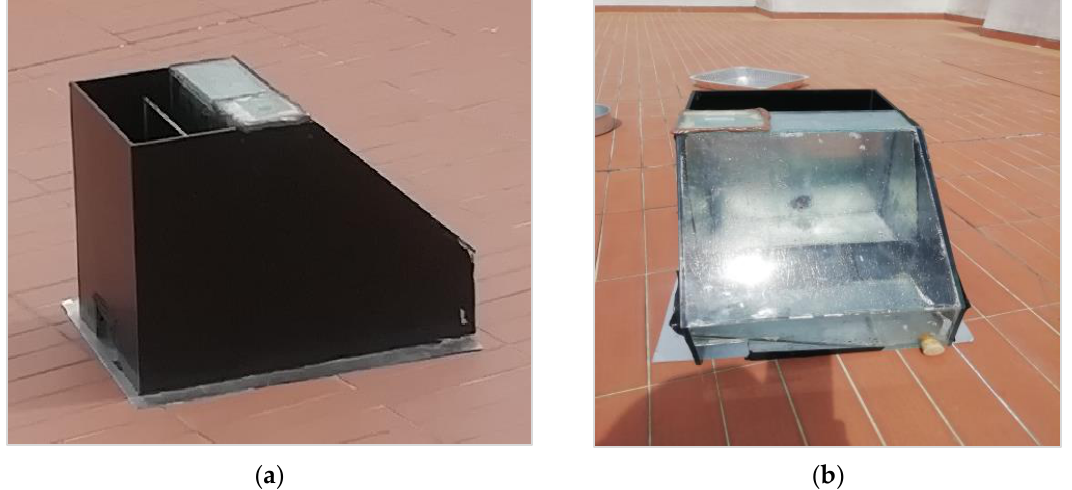
Figure 2. Solar still used in the field trials: ( a ) side view and ( b ) front view. The solar still is 0.50 m long and 0.30 m high and wide, respectively. The walls of the solar still were built in glass with a thickness of 5 mm and the water basin was in metal (area = 0.054 m 2 ). It was covered with black adhesive paper to improve the absorptivity of solar radiation and increase the internal heat of the solar still.